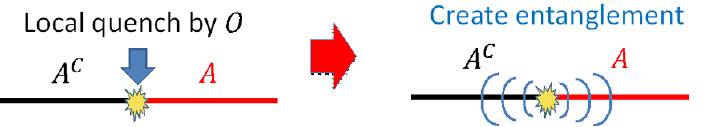
Figure 1 . We probe the growth of entanglement between A and A C after a local quench in this